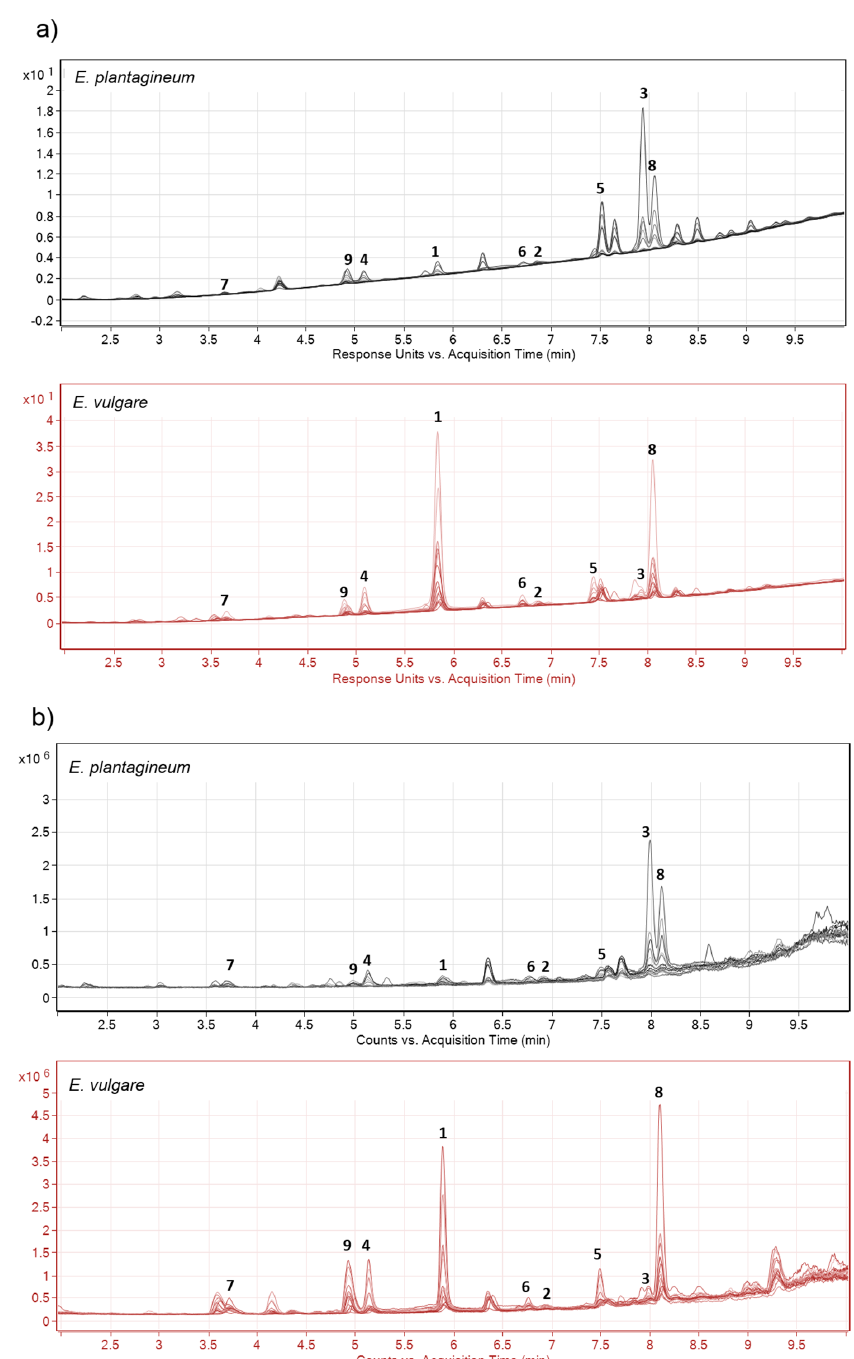
Figure 2. Chromatographic separation obtained from 12 selected field collected samples of Echium plantagineum and E. vulgare . ( a ) DAD chromatogram of root periderm extracts at wavelength 254 nm and ( b ) total ion chromatogram of the same extracts. Numbers 1 – 9 denote shikonins (Table 1).